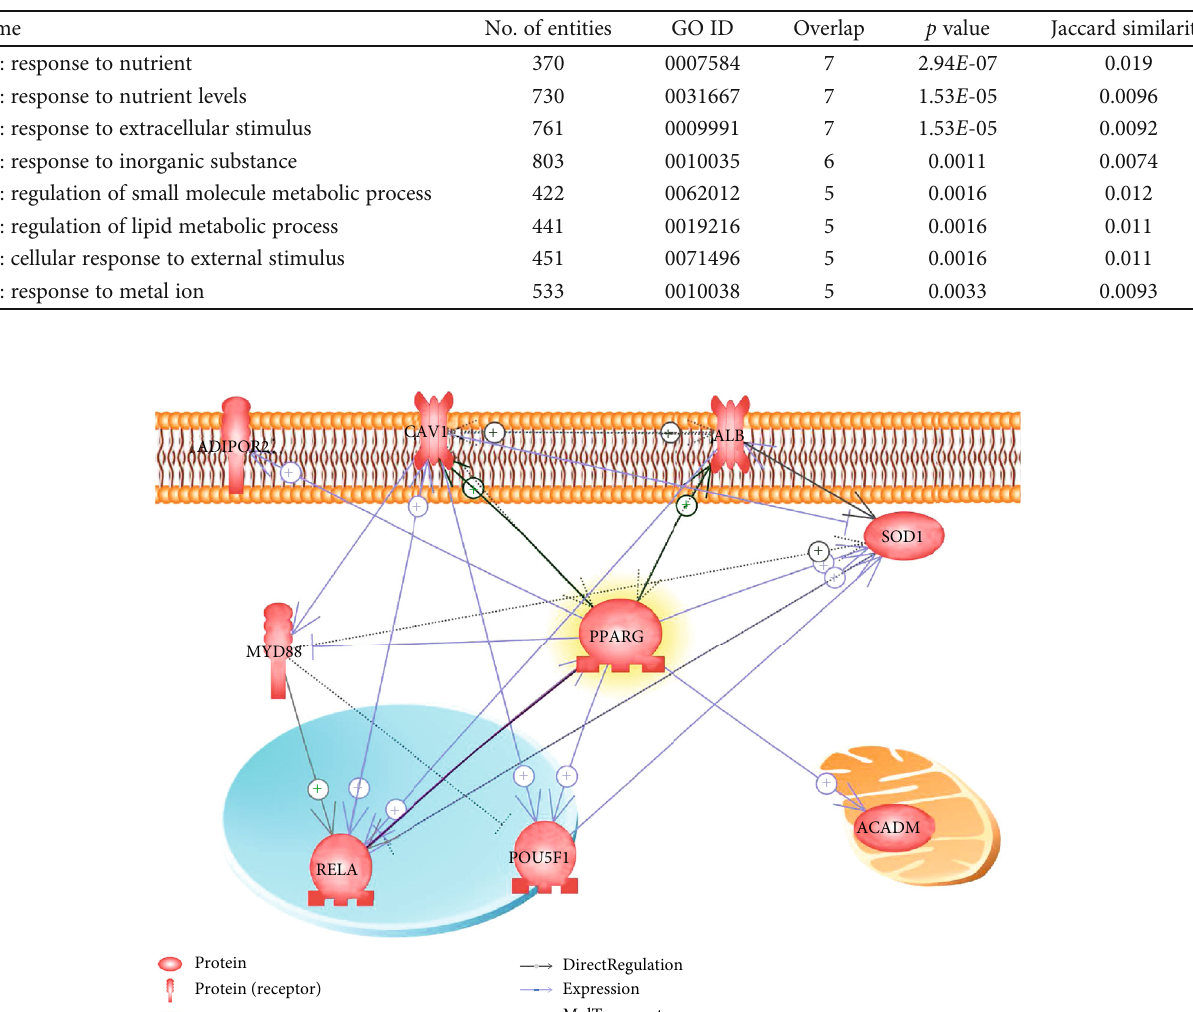
Table 3: The GO terms enriched with nine genes within the PPARG-MI functional network.